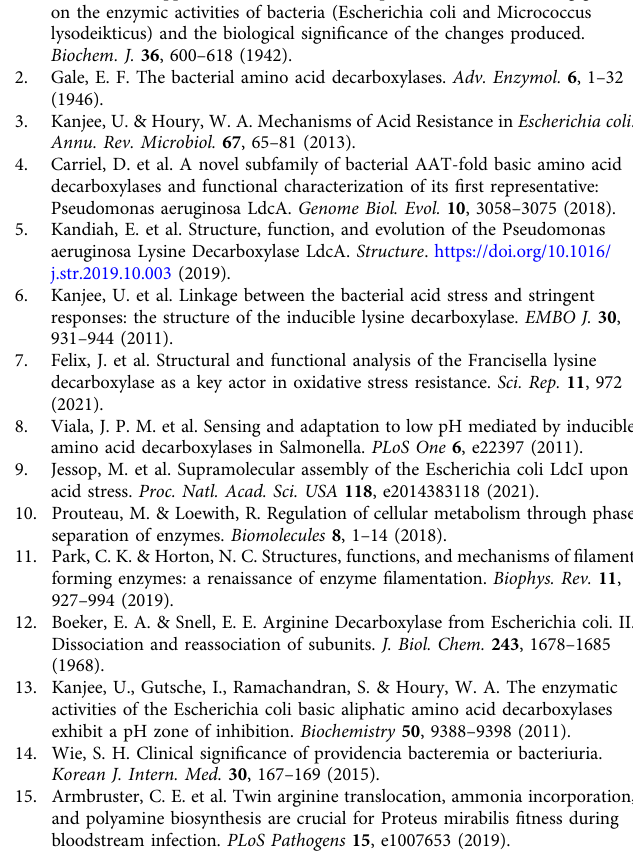
algorithm 47 with default parameters (Expect Threshold: 0,05, Word size: 6, Matrix: BLOSUM62, Gap Costs: Existence: 11, Extension: 1). Alignments were examined with AliView 48